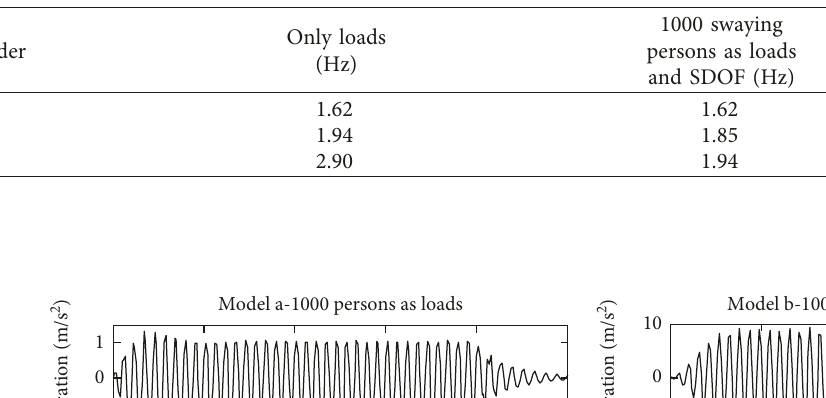
Figure 24: The VDVs of structural seating when 235 persons swaying. Table 11: Structural lateral natural frequency.